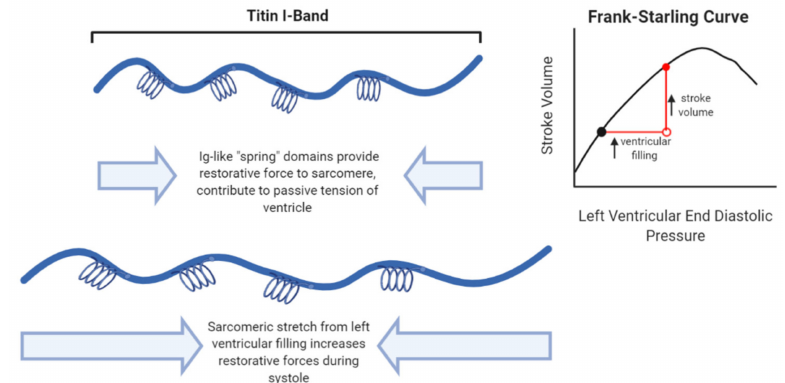
Figure 2. Titin’s I-band serves as a molecular spring that contributes to passive tension of the heart. The I-band is extensible due to Ig-like domains that serve as molecular springs. Because titin spans the sarcomere, the extensibility of the I-band imparts much of the resting tension of the cardiomyocyte. In addition, the I-band provides increased restorative forces when the ventricle and sarcomeres are stretched and contributes to the length dependent activation described in the Frank-Starling